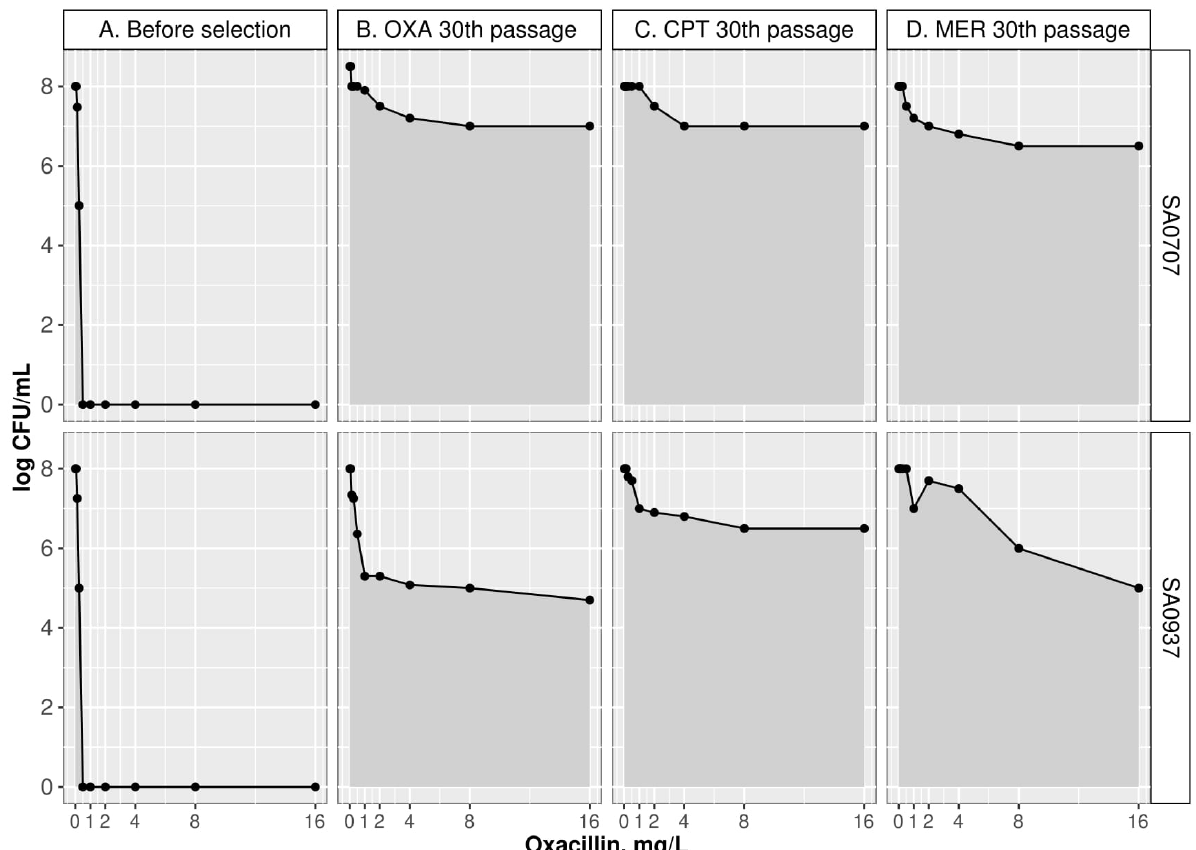
Figure 1. Population analysis profile (PAP) of parental isolates and their derivatives after 30 passages against oxacillin (OXA), ceftaroline (CPT), and meropenem (MER).